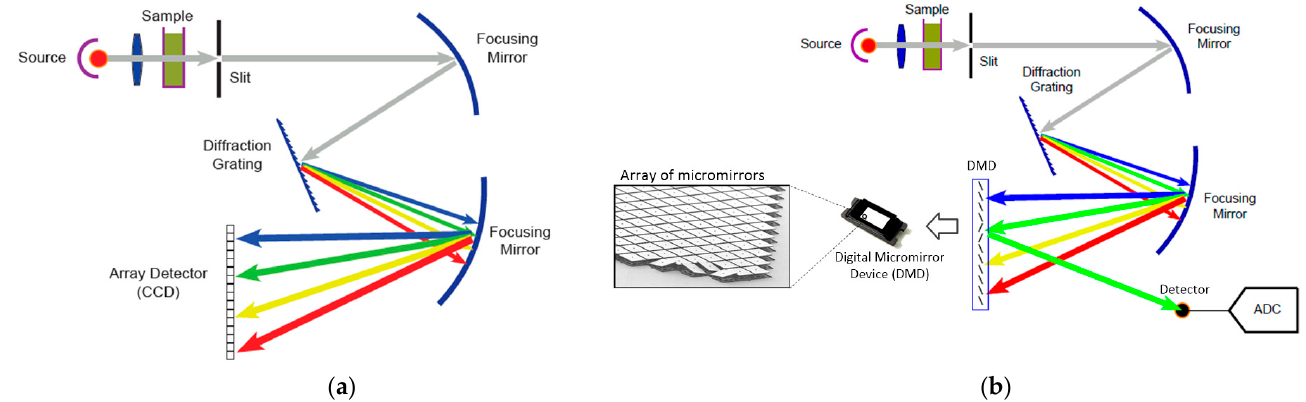
Figure 3. Spectroscopy architectures: ( a ) traditional ( b ) digital light processing (DLP).